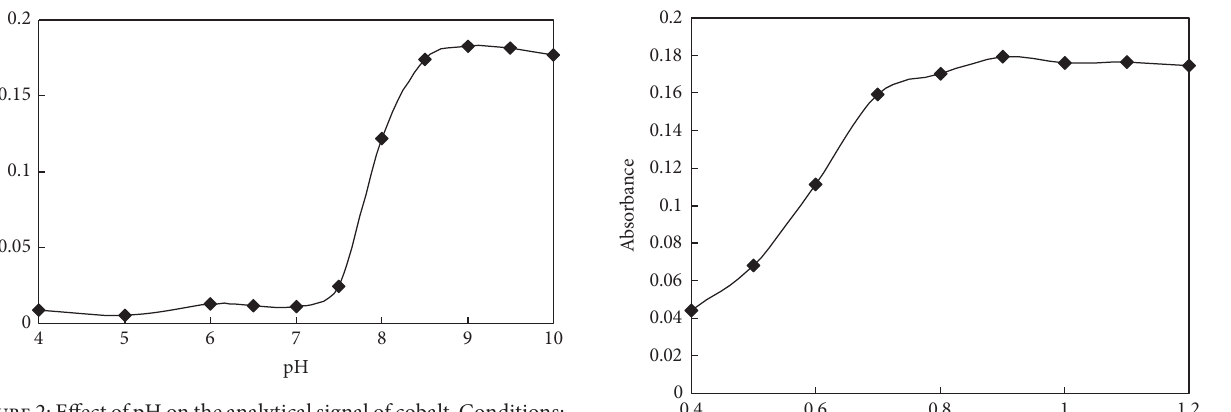
F 2: Effect of pH on the analytical signal of cobalt. Conditions: